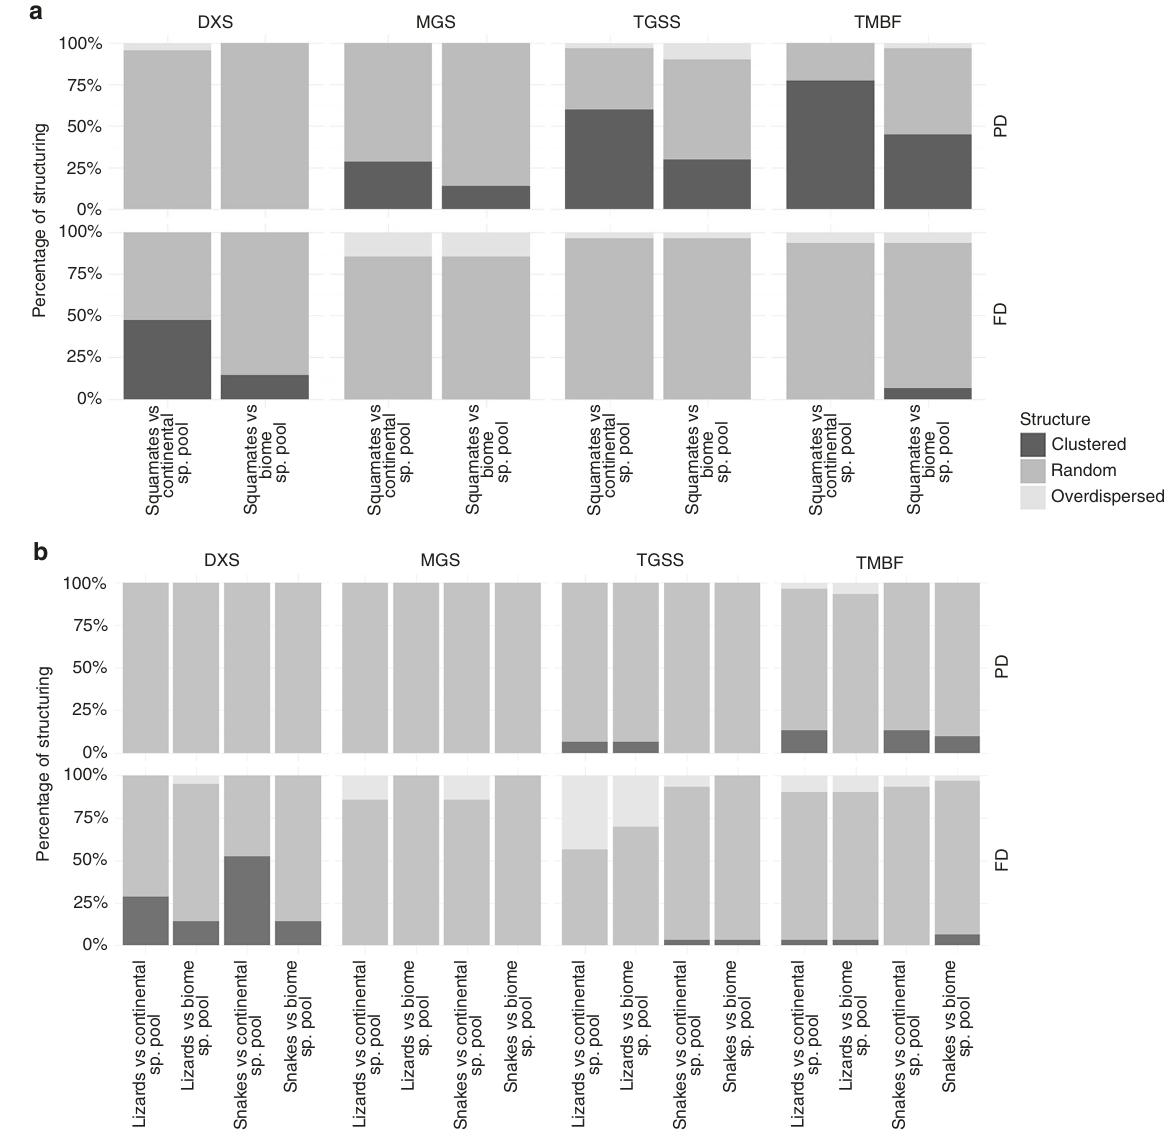
Fig. 2 Phylogenetic and functional diversity in different biomes. Proportions of signi fi cantly clustered, overdispersed and randomly structured local communities (NRI) in different biomes (95% CI), according to phylogenetic (PD) and functional (FD) diversity, tested against the continental and the biome species pool. a Complete data set of all African squamates. b Comparison of lizards and snakes. DXS deserts and xeric shrublands ( n = 21), MGS montane grasslands and shrublands ( n = 7), TGSS tropical grasslands, savannahs, and shrublands ( n = 30), TMBF tropical moist broadleaf forests ( n =